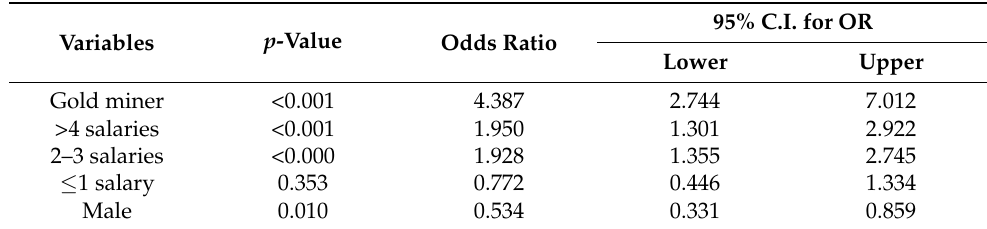
Table 2. Odds ratio for malaria positivity in individuals from a mining region in the Brazilian Amazon.